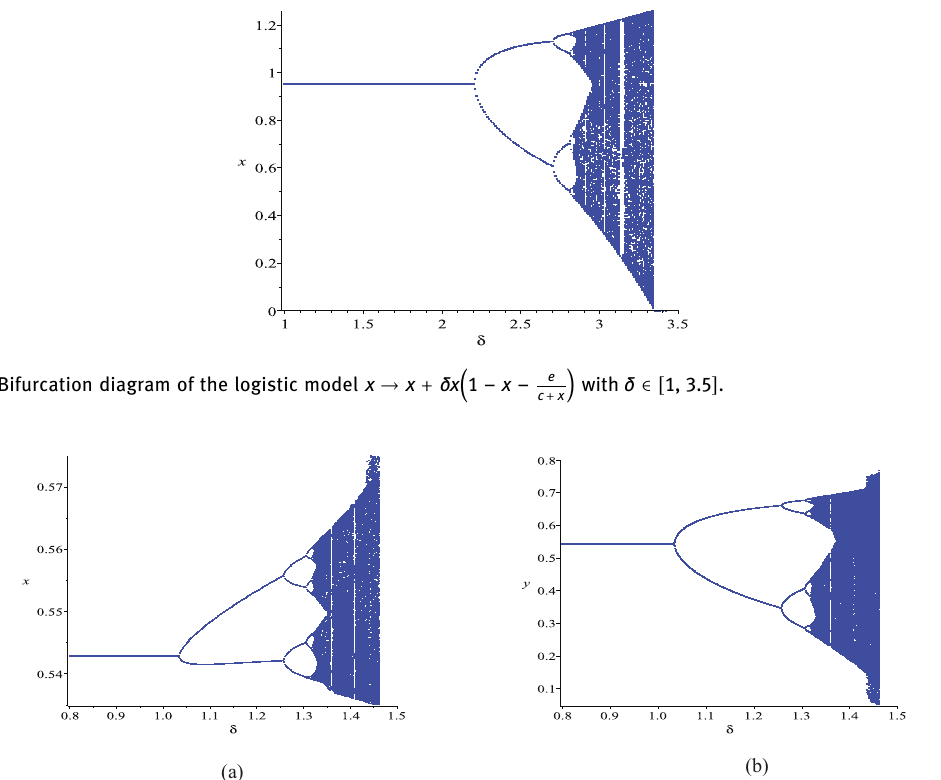
Figure 3: Flip bifurcation diagram of system ( 1.3 ) with parameters given in ( 4.2 ) and the initial value ( ) 0.3, 0.4 . ( a ) In the ( ) δ x , plane and ( b ) in the ( ) δ y , plane.